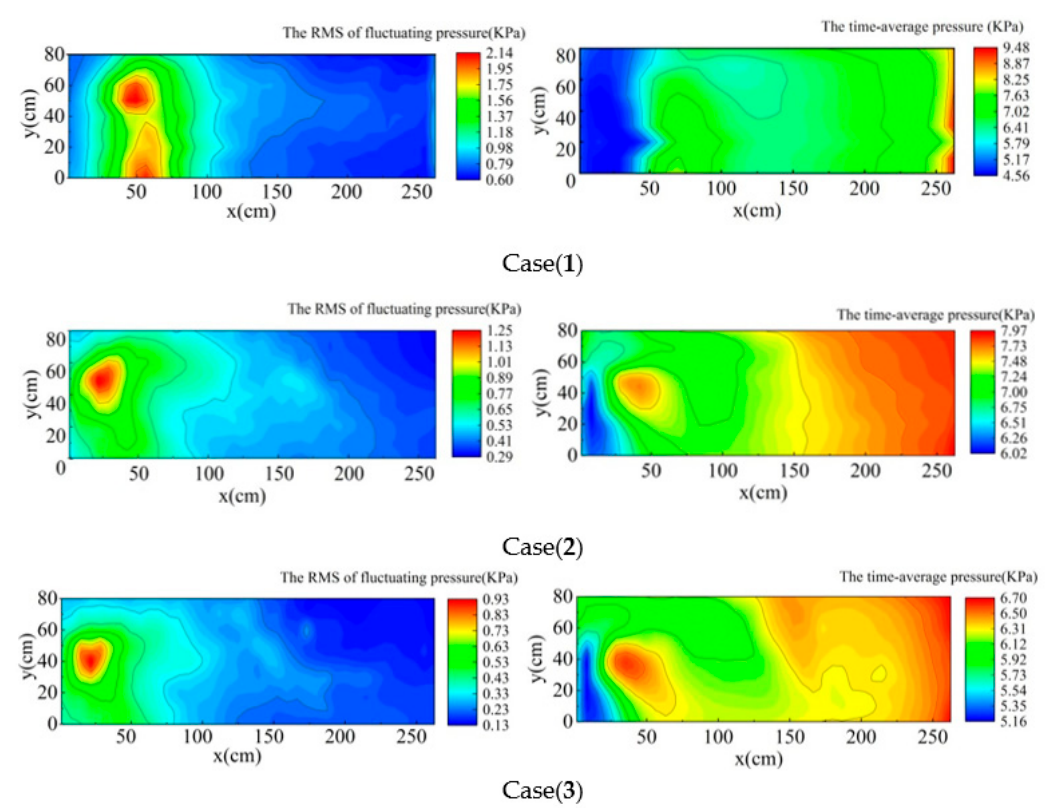
Figure 9. The distribution diagram of time-average pressure and RMS of fluctuating pressure of bottom of stilling basin under three cases.